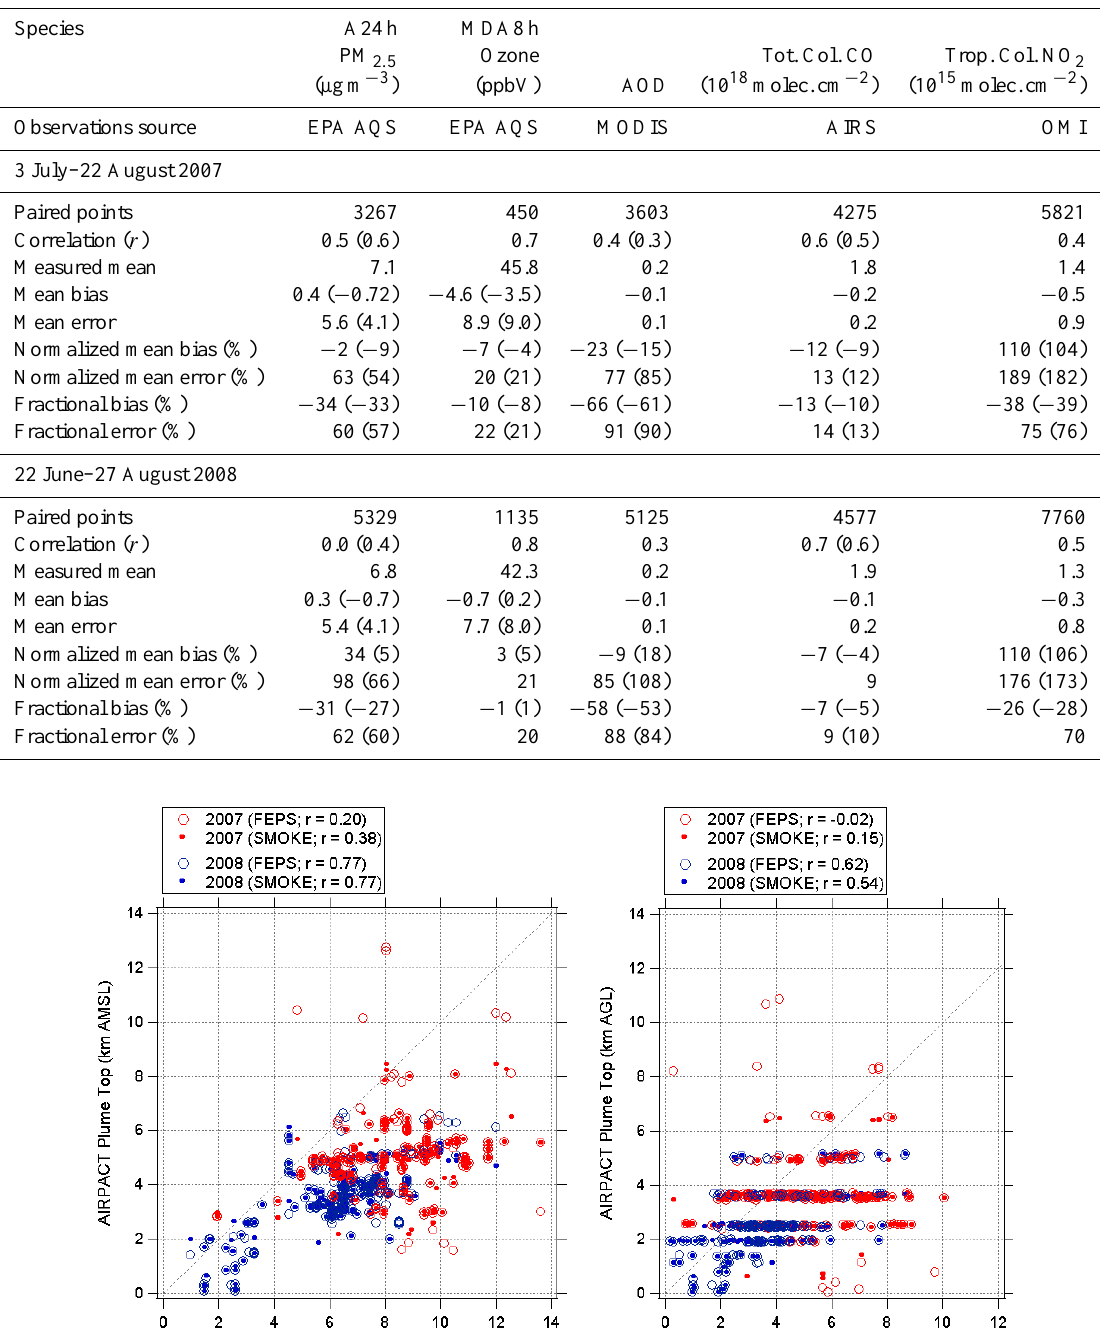
Table 3. Summary of FEPS plume-rise scenario comparisons (SMOKE plume-rise scenario shown in parentheses when different) from 3 July to 23 August 2007 (top) and 22 June to 27 August 2008 (bottom).